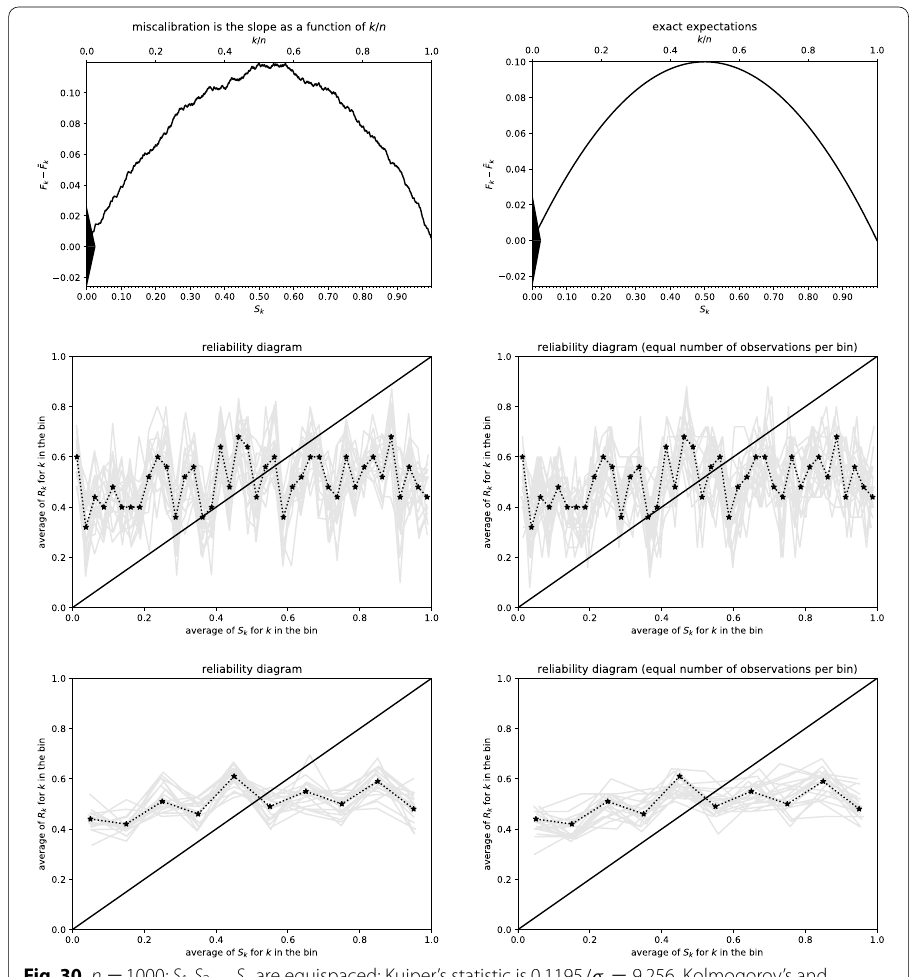
Fig. 30 n = 1000; S 1 , S 2 , ..., S n are equispaced; Kuiper’s statistic is 0.1195 /σ = 9.256 , Kolmogorov’s and Smirnov’s is 0.1195 /σ = 9.256 . Figure 31 displays the ground-truth reliability diagram. All plots, whether cumulative or conventional, appear to work well